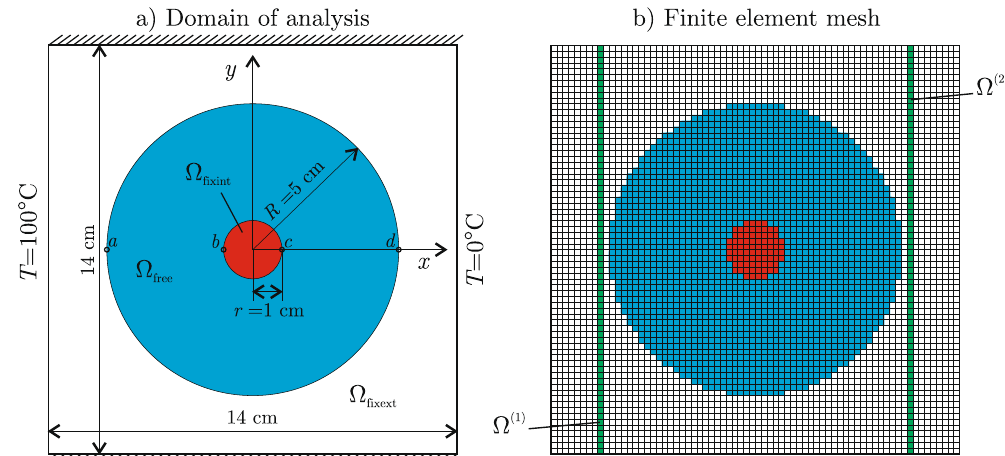
Figure 4. Heat flux concentration and cloaking example: ( a ) domain of analysis, ( b ) finite element mesh of Ω ; the blue elements belong to the device, while the red and the green ones have prescribed heat flux for concentration and cloaking, respectively.